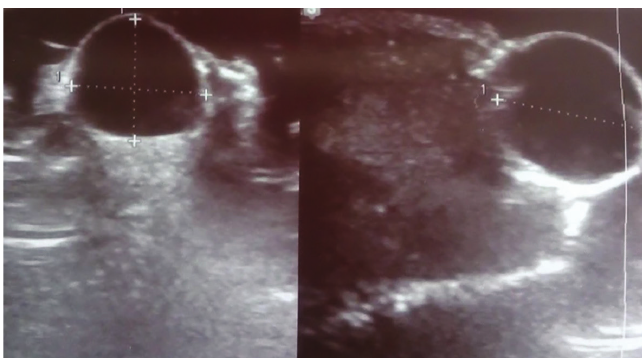
Figure 4 - a) Microscopic image (hematoxylin and eosin, 100X magnification) showing the squamous cell epithelium lining the cyst wall. Clinical characteristics of the median cyst of the penis in three large reviews Shao et al